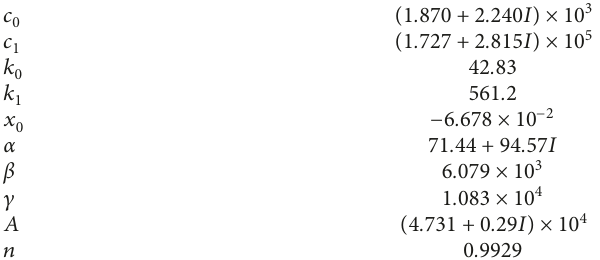
listed in Table 5. When I the greatest, as shown in Figure 13.